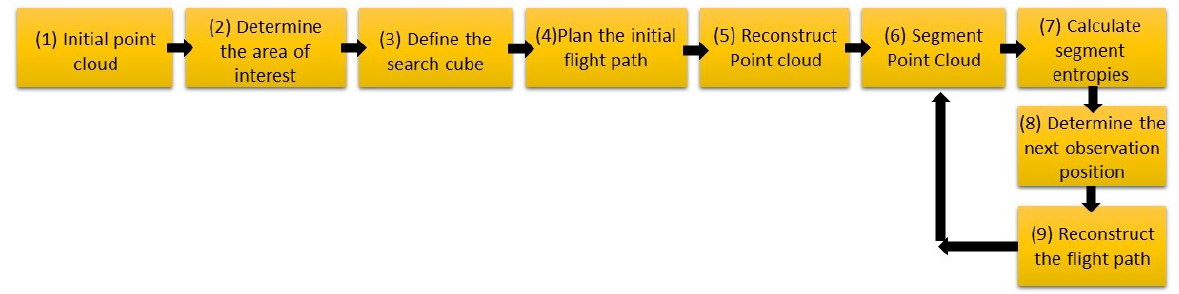
Figure 1. Work flow of the proposed autonomous UAV path planning